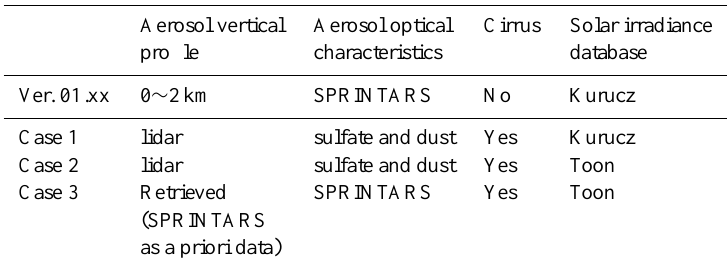
Fig. 2. Fig. 2. Vertical profiles of the backscattering ratio R , total depolarization ratio Dep, and wavelength exponent Alp, observed by lidar on 14, 20, and 23 February 2010. Tau (0.4–30km) is the partial optical thickness at altitudes of 0.4–30km at 532nm. Table 5. Physical parameters currently used for retrieval (Ver. 01.xx) and three case studies showing decreased biases of GOSAT SWIR XCO 2